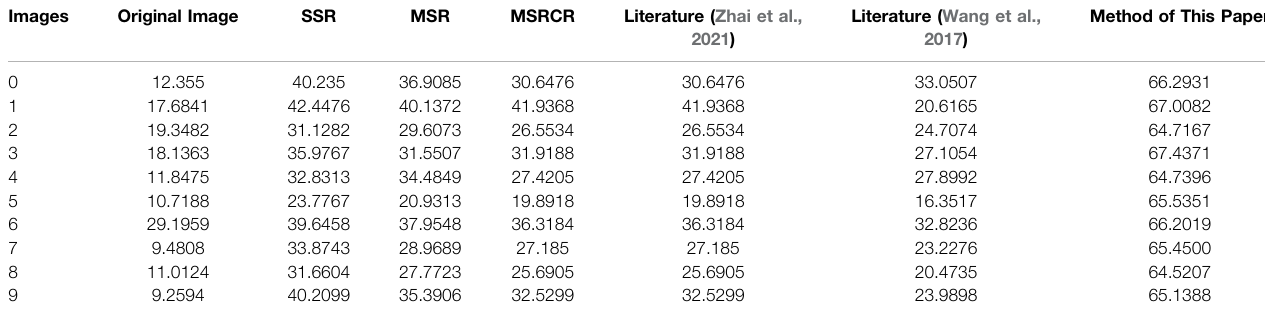
TABLE 3 | SD of low-illumination image enhancement with different algorithms. Images Original Image